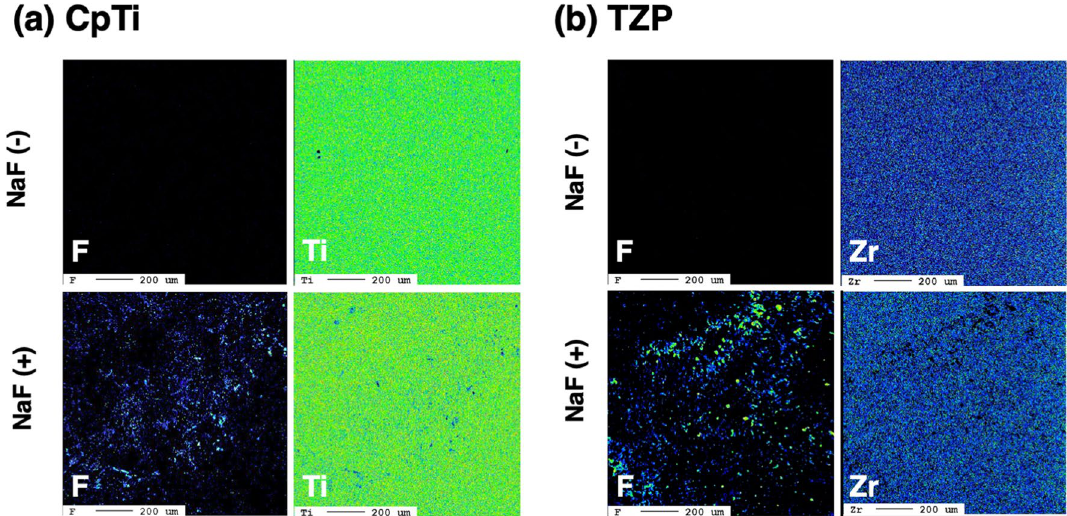
Figure 2. Use of EPMA in the analysis of CpTi ( a ) and TZP ( b ). EPMA was used to analyze up to a depth of 1 μm from the surface. ( a ) F was detected on NaF (+) surfaces, but not on NaF (−) surfaces. However, no signs of localization were observed. Ti was detected on both NaF (+) and NaF (−) surfaces. ( b ) F was detected on NaF (+) surfaces, but not on NaF (−) surfaces. However, no signs of localization were observed. Zr was detected on both NaF (+) and NaF (−)